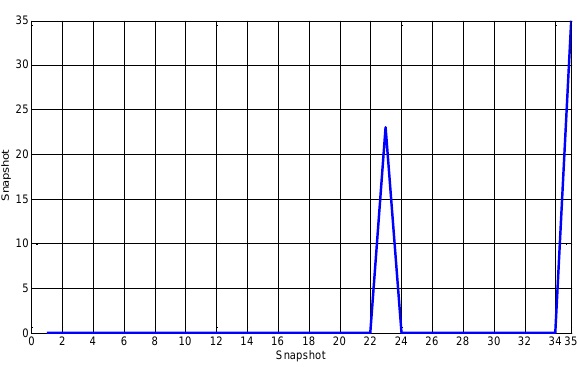
Fig.14 The number of erroneous snapshots (experiment 3,